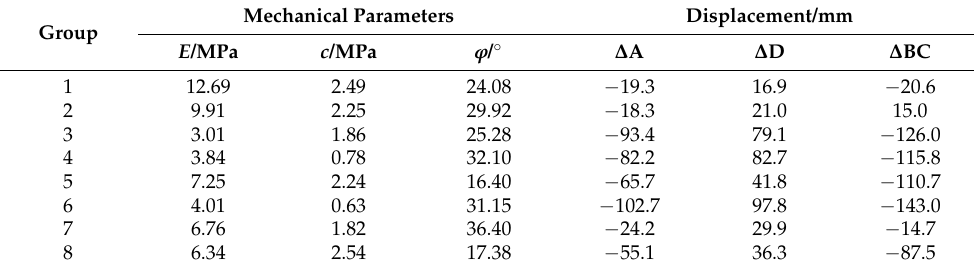
Table 3. The rock mechanical parameter and deformation for test samples.